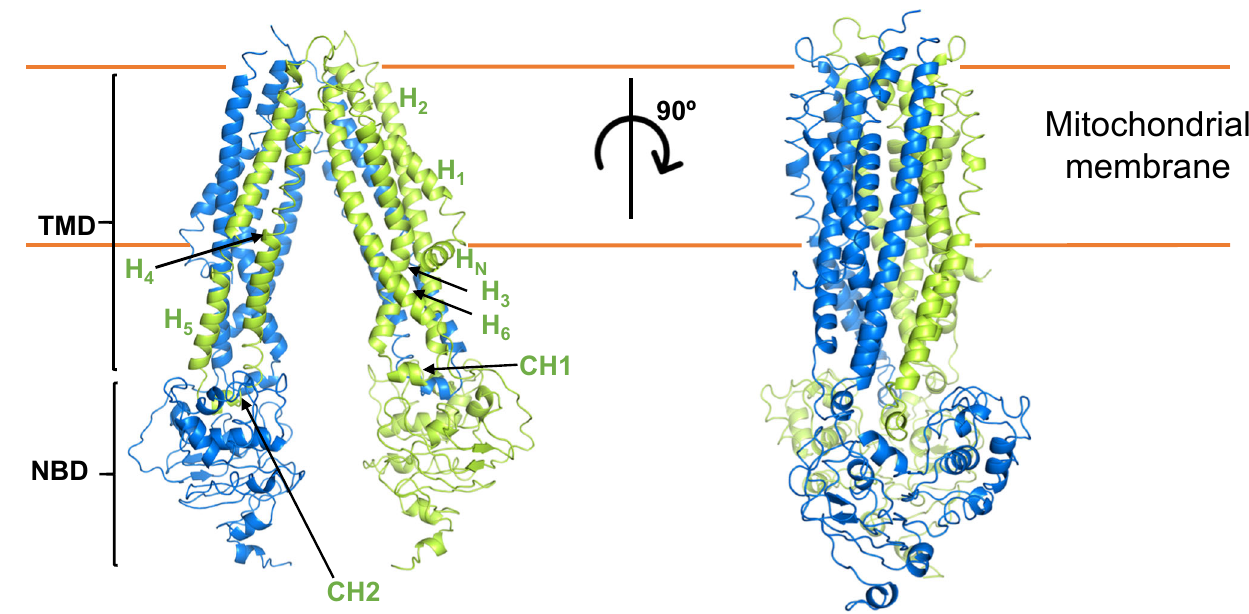
Fig. 2 | Structure of BV exporter, ABCB10-apo. Structure of ABCB10-apo in two differentorientations.Cartoondrawing of ABCB10-apo.ABCB10forms an inverted V-shape homodimer, each monomer (colored in marine and limon, respectively)